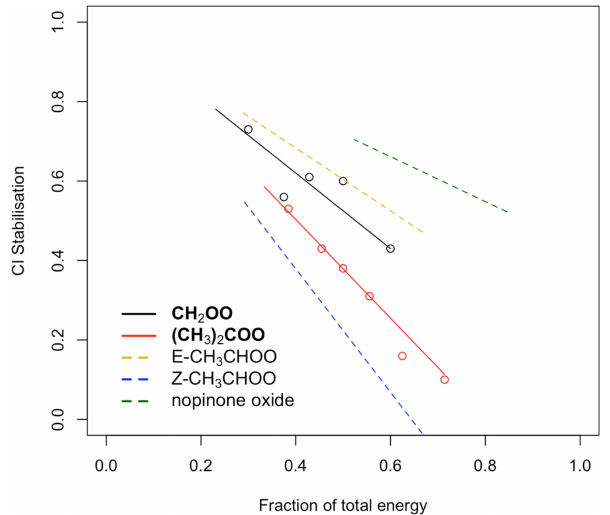
Figure 5. Dependence of CI ∗ stabilisation on the fraction of the total energy taken from the POZ. Black (CH 2 OO) and red ((CH 3 ) 2 COO) points: measurements taken from Newland et al. (2020). Solid and dashed lines: fits calculated using Eq.